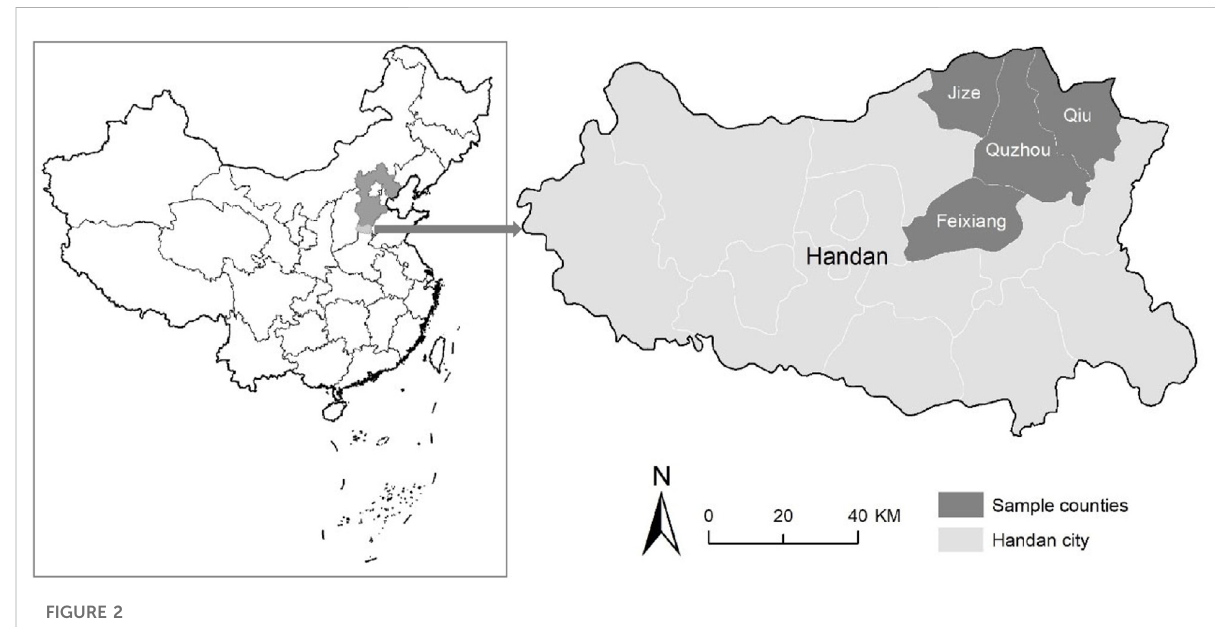
FIGURE 2 Geographical location of the study